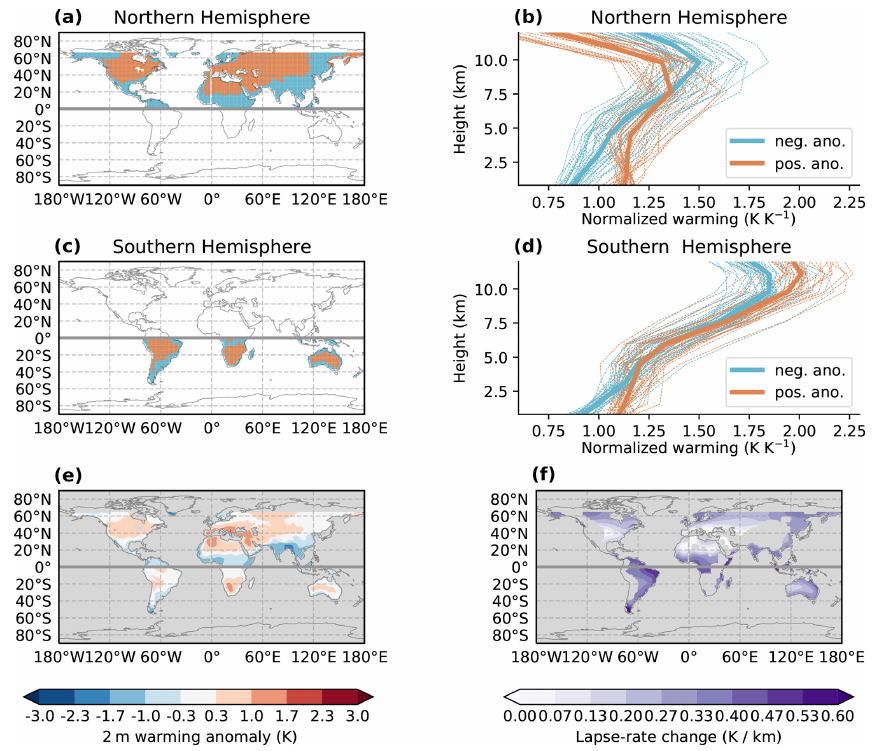
Figure A2. Same as Fig. 8 but for an ensemble of CMIP5 simulations consisting of the following models: ACCESS1-0, ACCESS1- 3, BCC-CSM1-1, BCC-CSM1-1-m, BNU-ESM, CanESM2, CESM1-BGC, CESM1-CAM5, CESM1-CAM5-1-FV2, CESM1-WACCM, CMCC-CESM, CMCC-CM, CMCC-CMS, CNRM-CM5, CSIRO-Mk3-6-0, FGOALS-g2, FIO-ESM, GFDL-CM3, GFDL-ESM2G, GFDL- ESM2M, GISS-E2-H, GISS-E2-H-CC, GISS-E2-R, GISS-E2-R-CC, HadGEM2-AO, HadGEM2-CC, HadGEM2-ES, INM-CM4, IPSL- CM5A-LR, IPSL-CM5A-MR, IPSL-CM5B-LR, MIROC5, MIROC-ESM, MIROC-ESM-CHEM, MPI-ESM-LR, MPI-ESM-MR, MRI- CGCM3, and